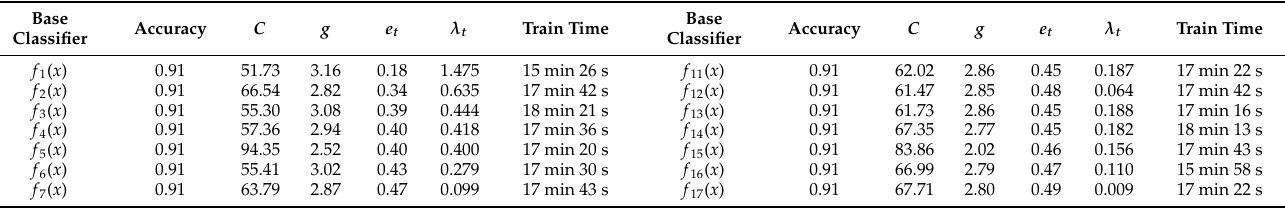
Table A3. Training results of the 20 GA-SVM base